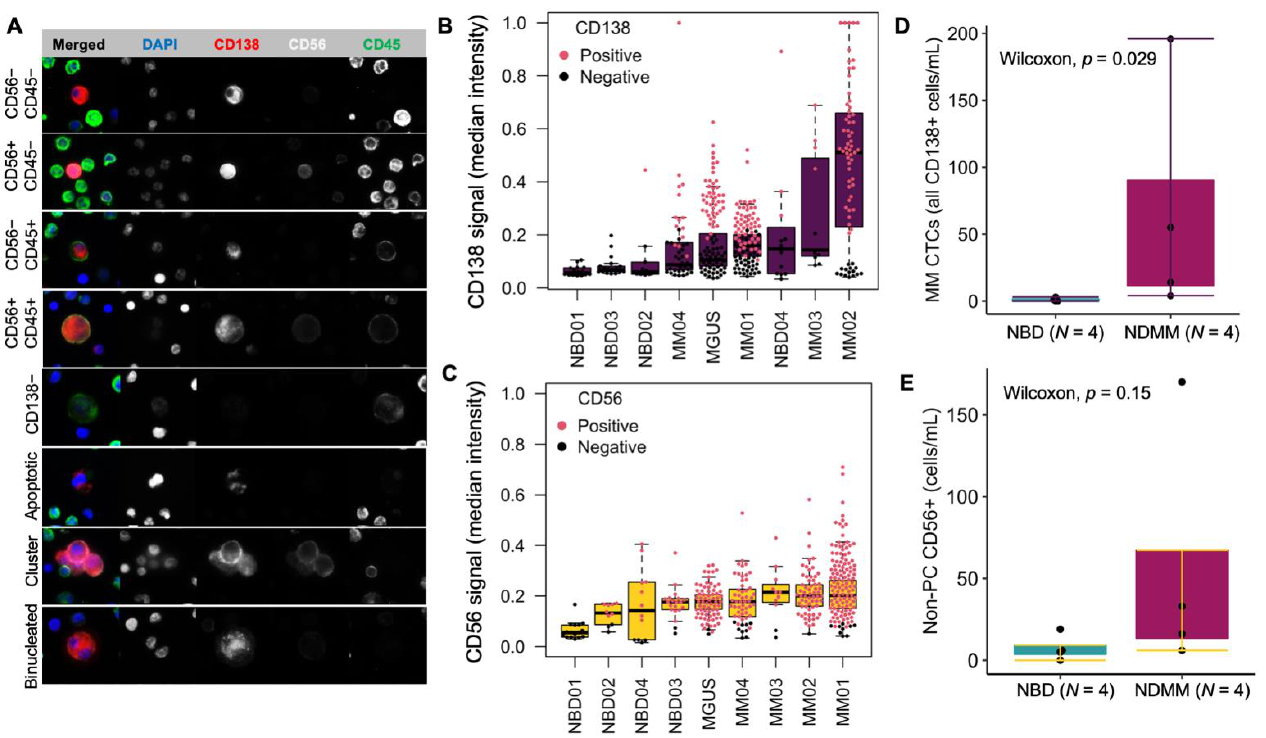
Figure 3. Morphological Characterization of MM CTCs and BMPCs. ( A ) Microscopy images of representative cells from morphological subtypes of PB and BMA cells. ( B ) CD138 and ( C ) CD56: signal intensity in circulating rare cells across samples, colored by positive or negative marker expression based on manual classification. ( D ) Statistical comparison of MM CTC count between NDMM and NBD. ( E ) Statistical comparison of non-plasma cell CD56 positive cells (sum of CD56+ and CD56+CD45+ cells).